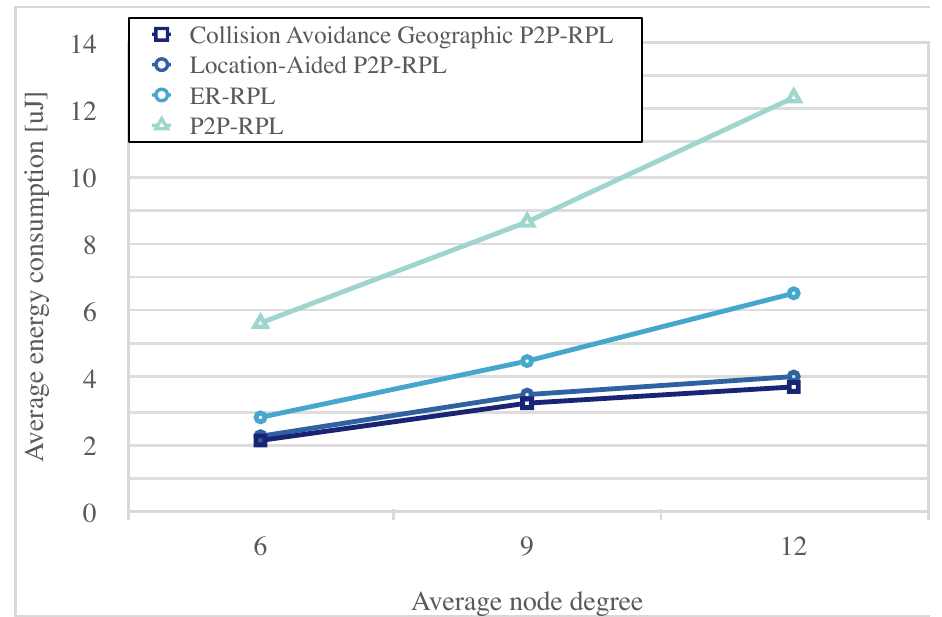
Figure 9. The average energy consumption versus the average node degree.